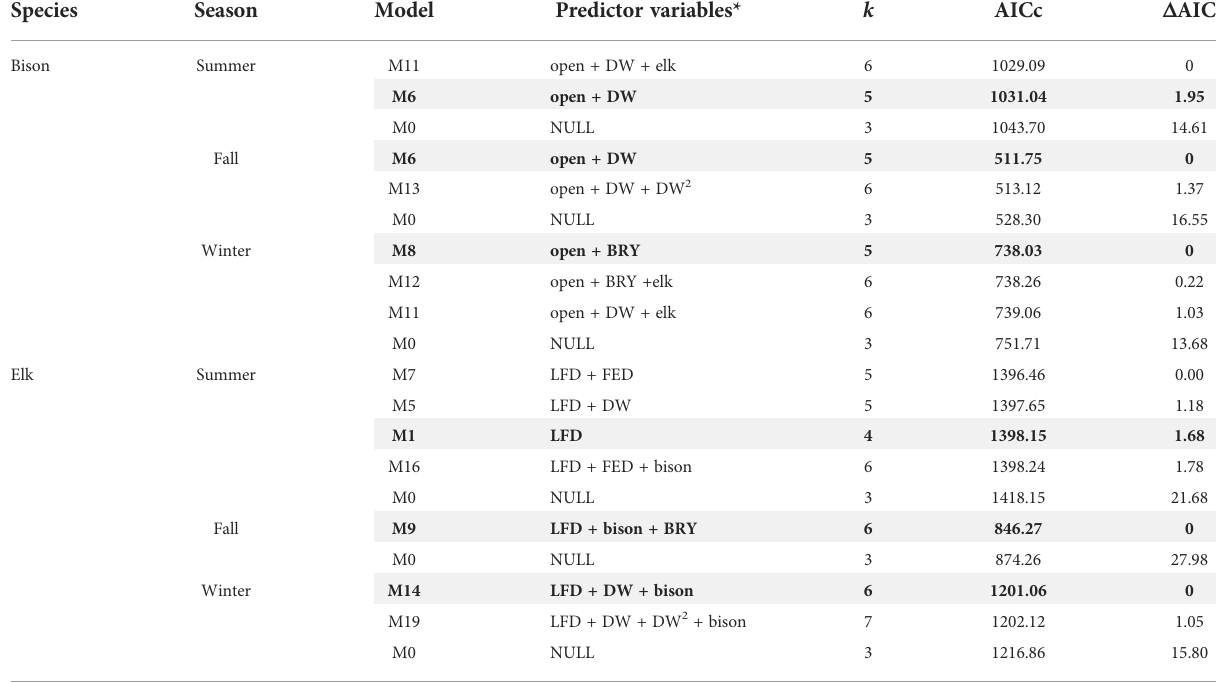
TABLE 2 Model selection table of the top-ranked models and null models for bison and elk in summer, fall, and winter.